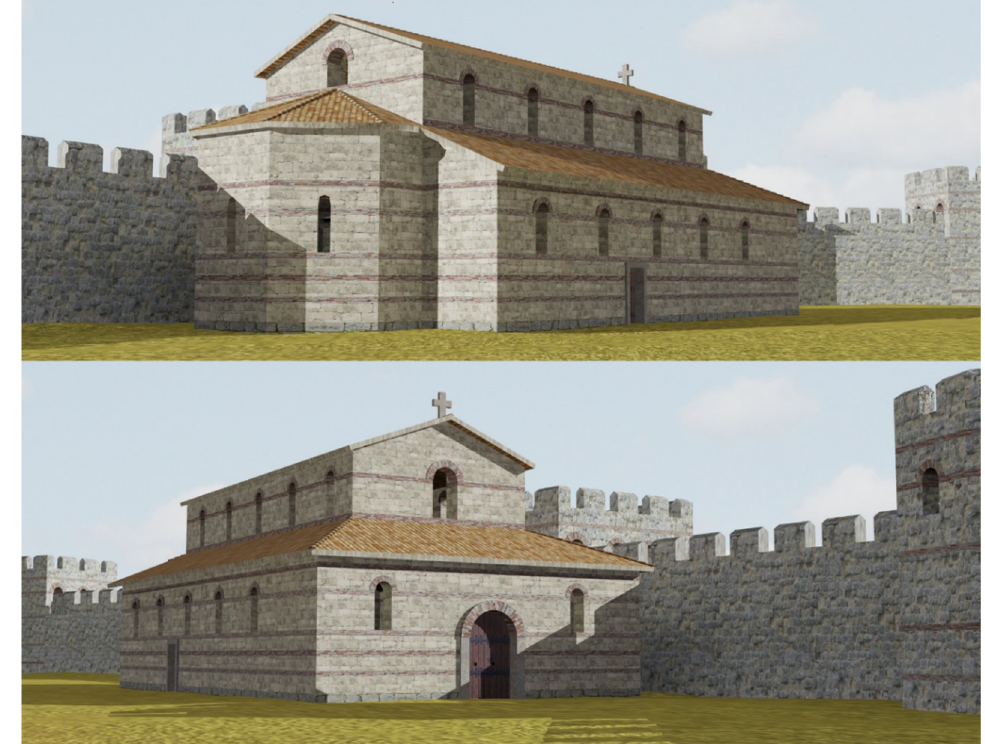
Figure 14. Reconstruction of the appearance of the Church No.